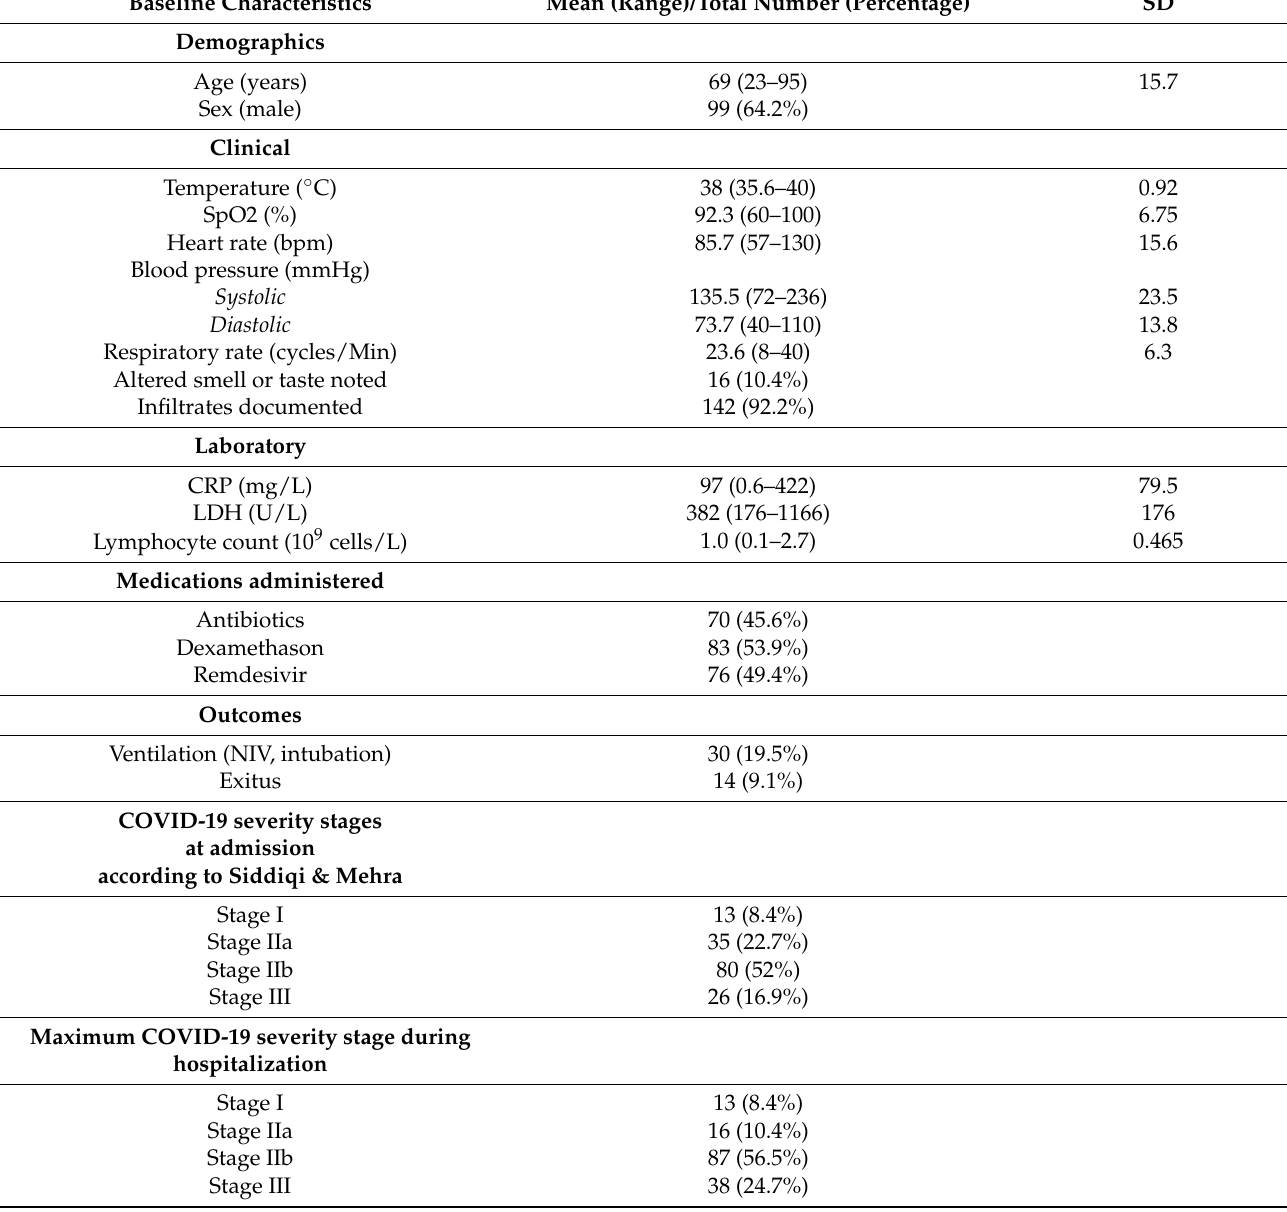
Table 1. Baseline characteristics, including COVID-19 stages, AIFELL scores and clinical and labora- tory values ( n =